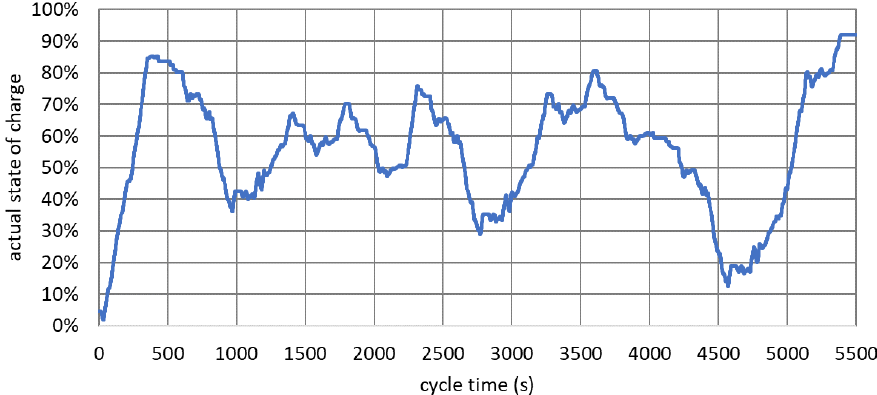
Figure 5. Example of the state of charge of the battery in an FCEV (truck light, hilly terrain, and WLTP triple-mixed drive WLTP triple-mixed drive cycle).